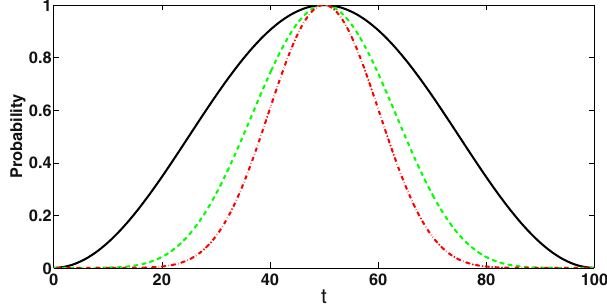
Figure 1. Time evolution of probability for the coupled cavity to be in − N 0, 1 on evolution from the initial state − N 1, 0 , with J = 10 − 2 π . By duality, these profiles show the probability of detecting a single photon in N th (end) cavity in the cavity array. Different curves correspond to N = 2 (continuous), 4 (dashed)and 6 (dot-